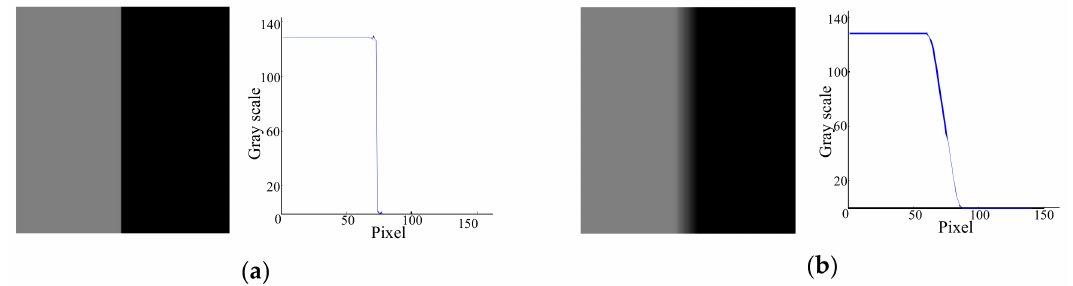
Figure 7. The change in gray scale: ( a ) Clear image; and ( b ) Blurred image.